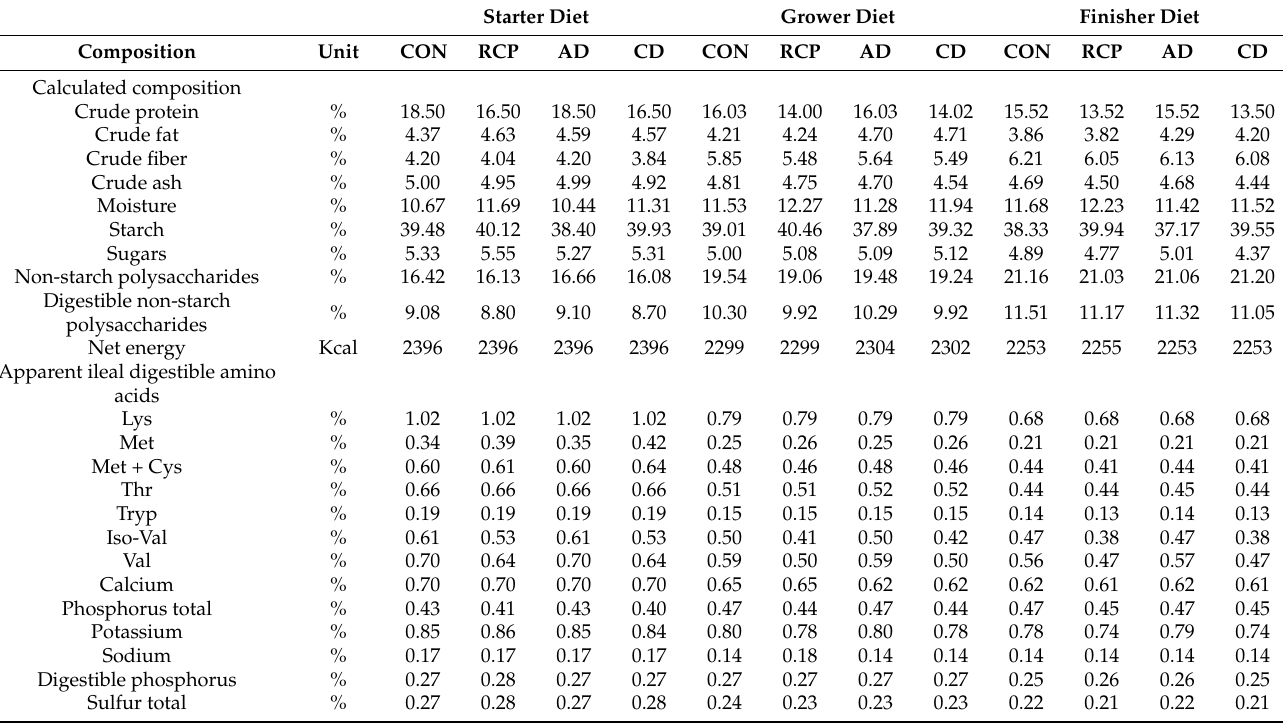
Table 2. Nutrient compositions of experimental diets, as fed